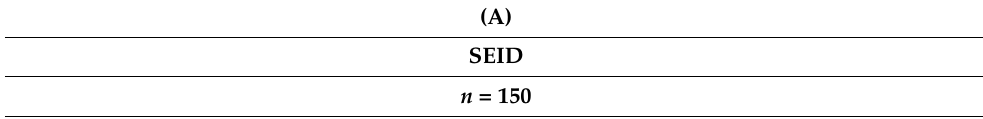
Table 3. Opinion of SEID patients about SEID terminology and the image given by this new name in different social areas (A). Free comments analysis (B). r , number of respondents for each item;